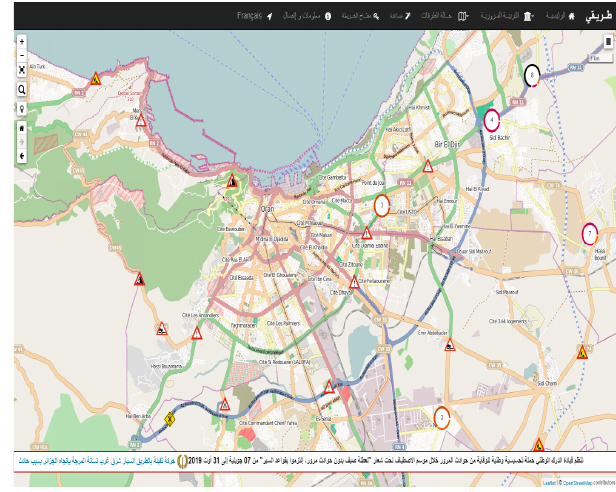
Figure 5. Figure TARIKI site web Interface